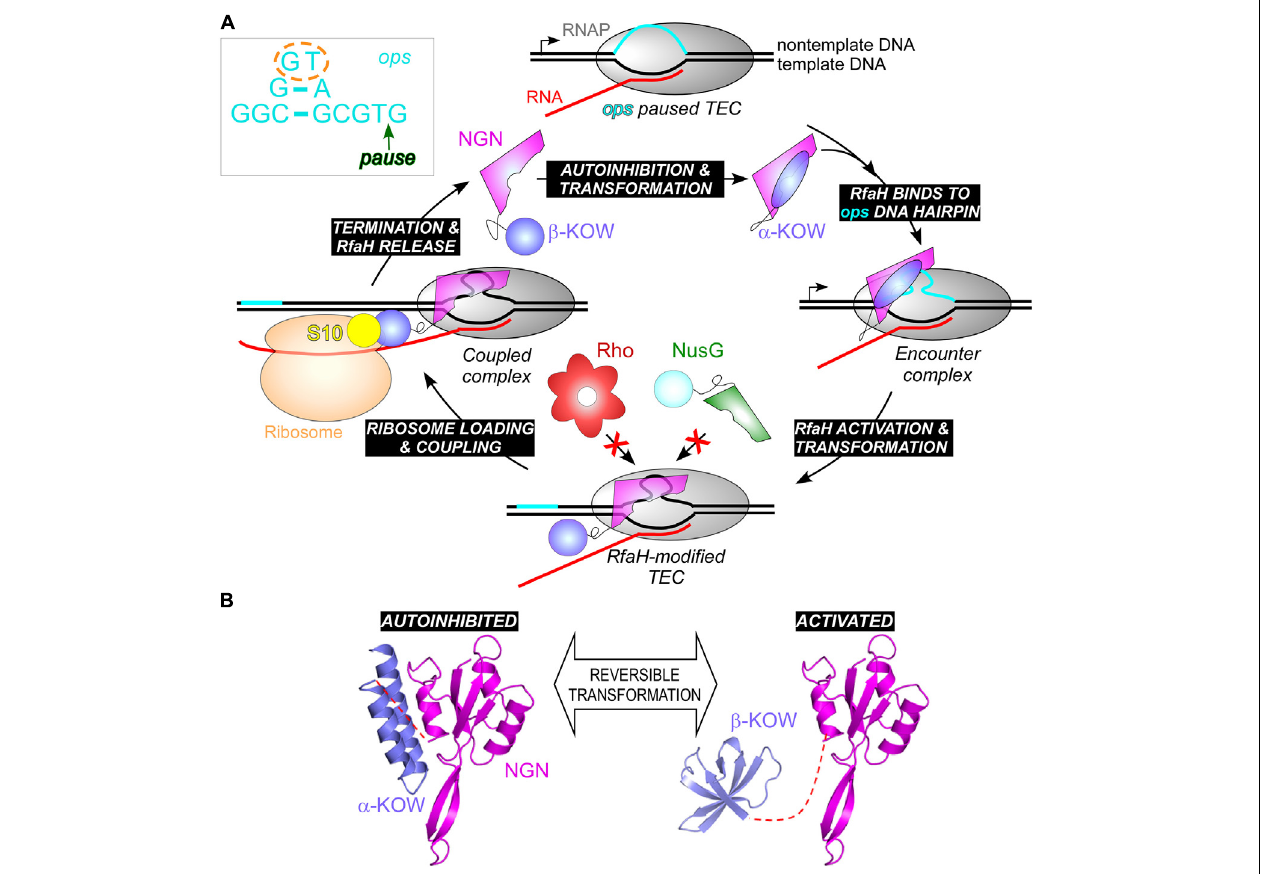
FIGURE 9 | (A) A full cycle of RfaH; see text for details. The inset shows the ops DNA element, which forms a short hairpin on the TEC surface; ops bases that make most interactions with RfaH in the complex are circled; the pause position is indicated by an arrow. (B) RfaH domain dissociation and refolding. PDB IDs: autoinhibited RfaH, 5OND; activated RfaH,